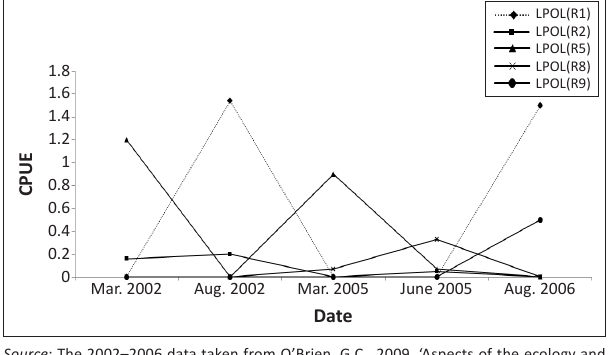
FIGURE 4: Temporal trends in the catch per unit effort (number of fish per minute) of Labeobarbus polylepis collected in the Elands River between 2002 and